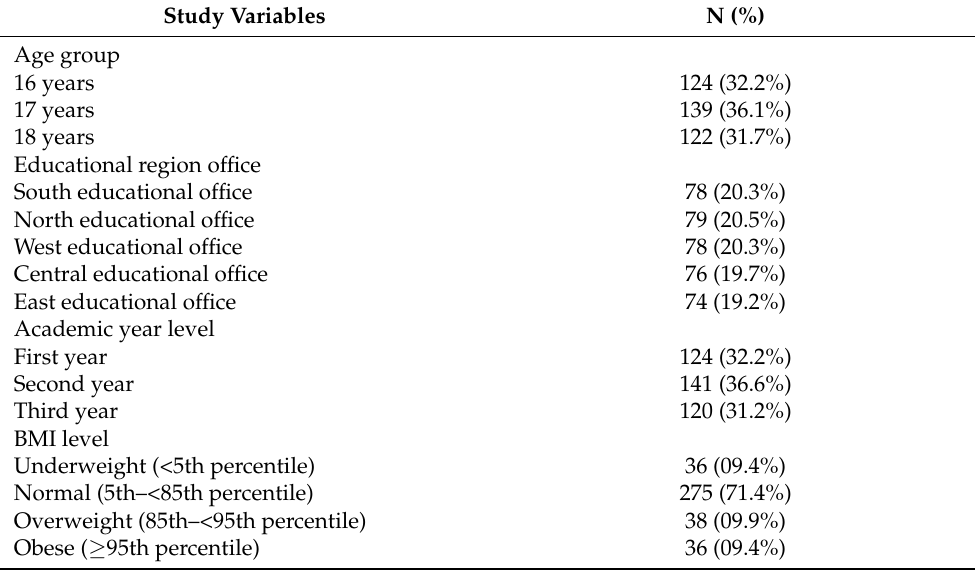
Table 1. Sociodemographic characteristics of the participants ( n = 385).